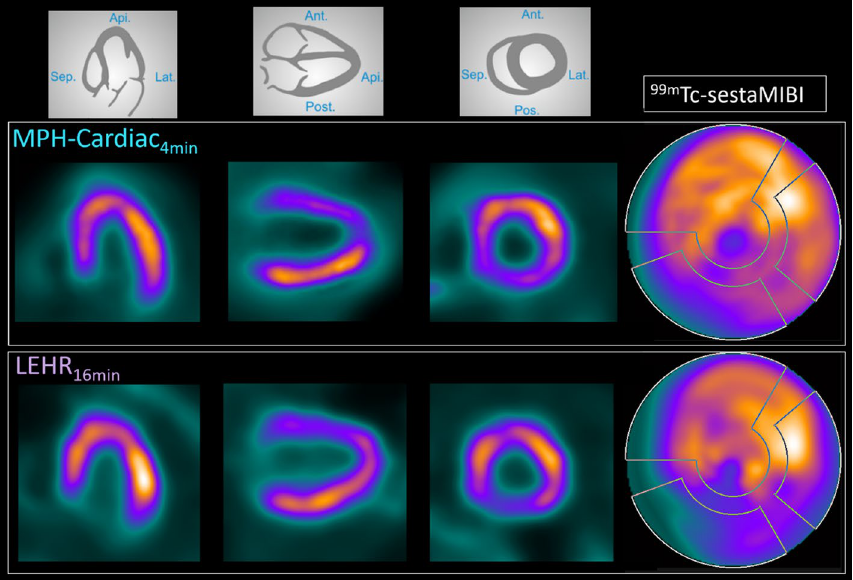
Fig. 5 Representative post‑stress SPECT image slices and polar maps of a 67 years old male CAD patient. Reconstructed images of the four minutes MPH‑Cardiac acquisition (upper row) and sixteen minutes LEHR acquisition (lower